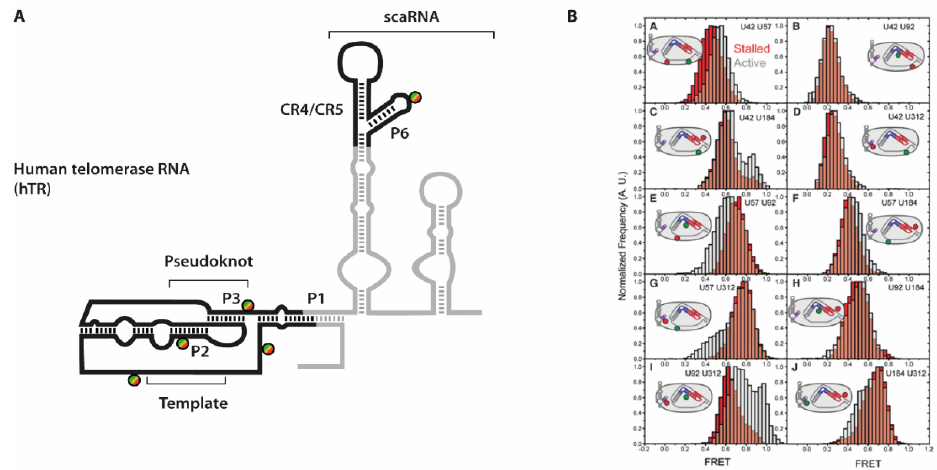
Figure 7. ( A ) Secondary structure of human telomerase RNA hTR with labeling sites. The parts in grey are representing the full RNA, while the parts in black have been used in the study [24]. ( B ) smFRET histograms derived from the ten labeling site combinations. Data derived from the stalled complex is depicted in red, while complexes selected for activity are in grey. Figure 7B is taken from Parks et al. and used under Creative Commons Non-Commercial License (CC-BY NC).